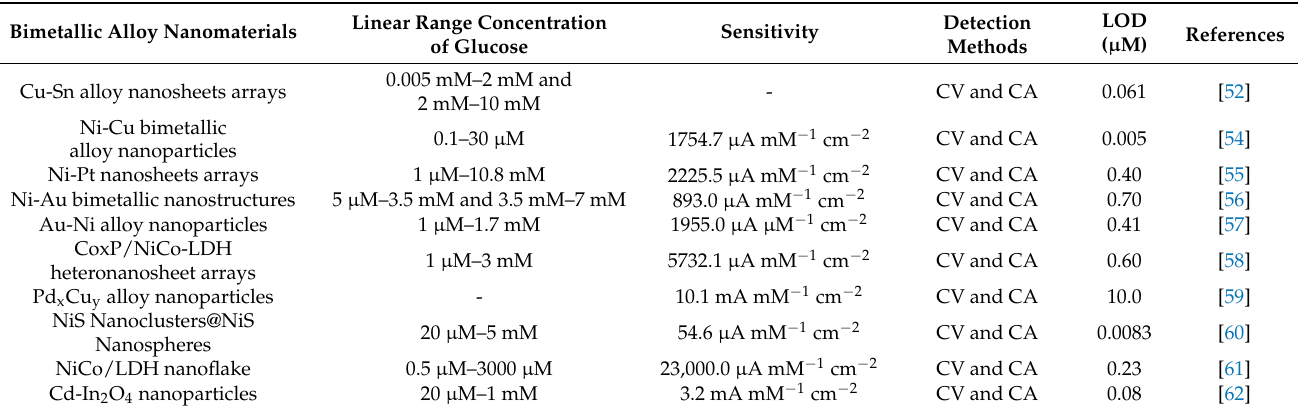
Figure 3. (Left): Schematic fabrication of Cu-Sn alloy nanosheet arrays. (Right): ( A ) CVs obtained for CP, Sn/CP, Cu/CP, and Cu-Sn/CP electrodes in the presence of 1 mM glucose in 0.1 M NaOH at a scan rate of 100 mV s − 1 ; ( B ) LSVs obtained for Cu-Sn/CP electrode using various concentrations of glucose in 0.1 M NaOH at a scan rate of 100 mV s − 1 ; ( C ) CVs obtained for Cu-Sn/CP electrode in the presence of 1 mM glucose in 0.1 M NaOH at various scanning rates; ( D ) plot obtained used as the function of glucose oxidation peak currents vs. the various scan rates. Reproduced with permission from Ref. [52]. Table 1. Bimetallic or Bimetallic alloy nanomaterials based glucose sensor fabrication schemes and their analytical